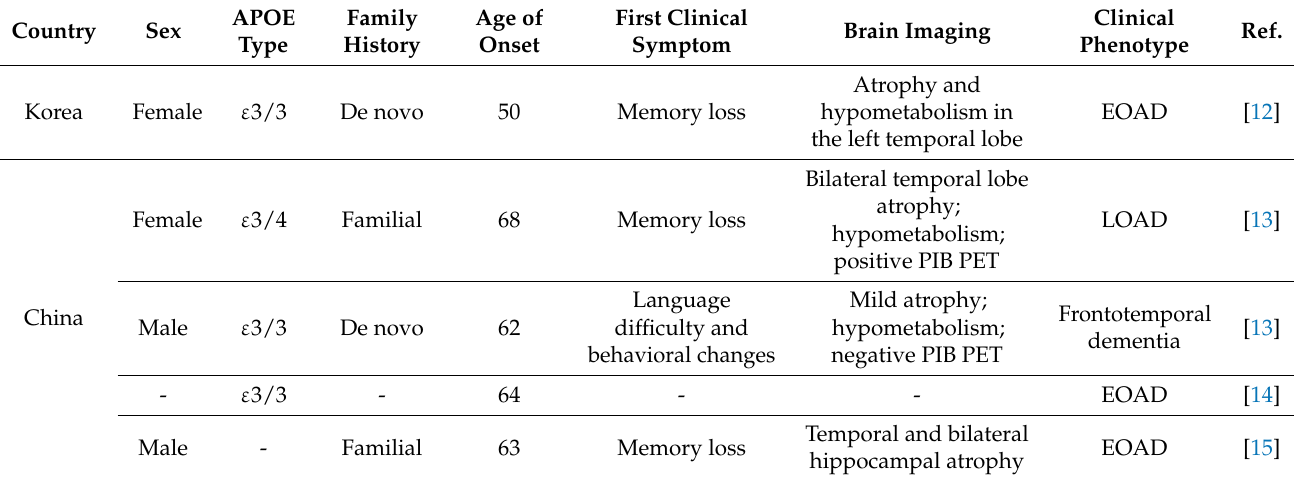
Table 2. List of previously reported patients with PSEN2 His169Asn